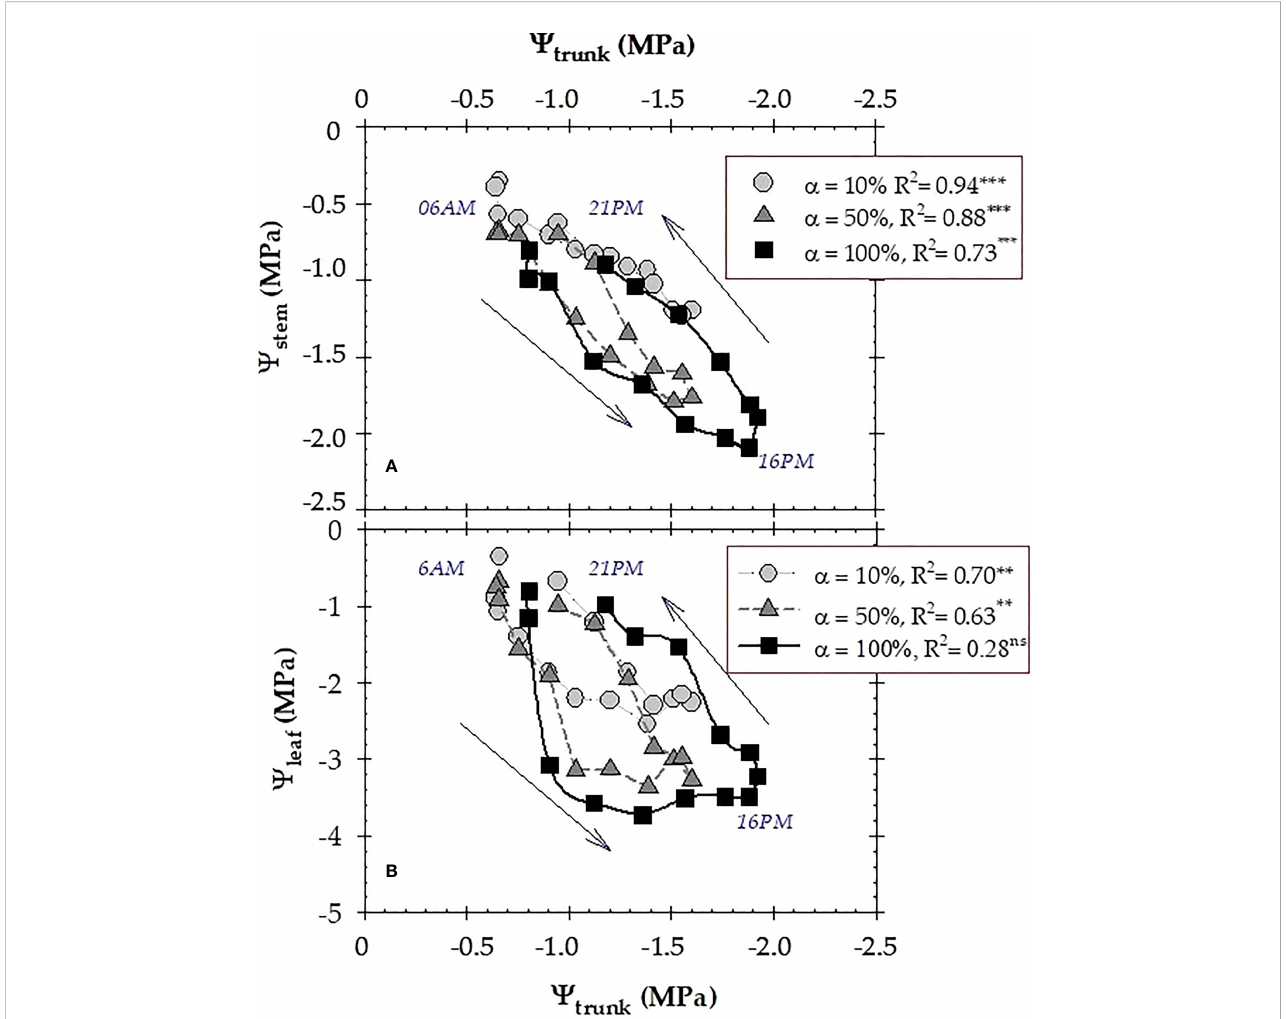
FIGURE 8 Daily time-course of the relationship between trunk water potential ( Y trunk ) and: (A) stem water potential ( Y stem ) and (B) leaf water potential ( Y leaf ) at each irrigation criterion: 10% (well-irrigated), 50% (moderate water de fi cit) and 100% (severe water de fi cit, non-irrigated), respectively. The data point is the mean of four leaves. R 2 is the coef fi cient of determination of the linear regression. **: p ≤ 0.01; ***: p ≤ 0.001, ns: not signi fi